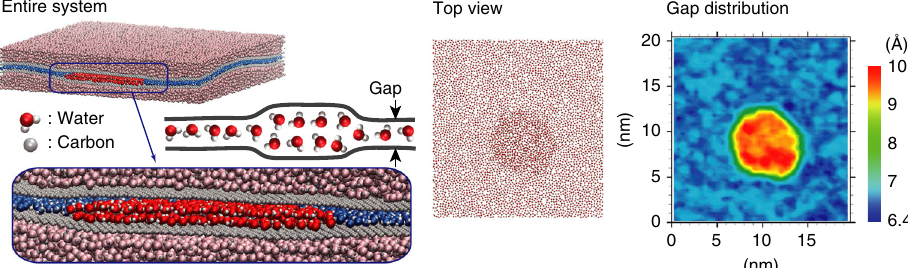
Fig. 1 Simulated system, and a schematic representation of the two-dimensional droplet “ dripplon ” . The two fl exible graphene sheets with water molecules in between are sandwiched by two water reservoirs ( fi xing a hydrostatic pressure of 1 atm). The top view of the con fi ned water molecules is also shown, along with the corresponding fi gure showing the distribution of the gap between the two graphene sheets. The water molecules in the reservoirs are light colored to focus on the con fi ned water. The water molecules belonging to the dripplon are color-highlighted in red, whereas the con fi ned water molecules outside the dripplon are